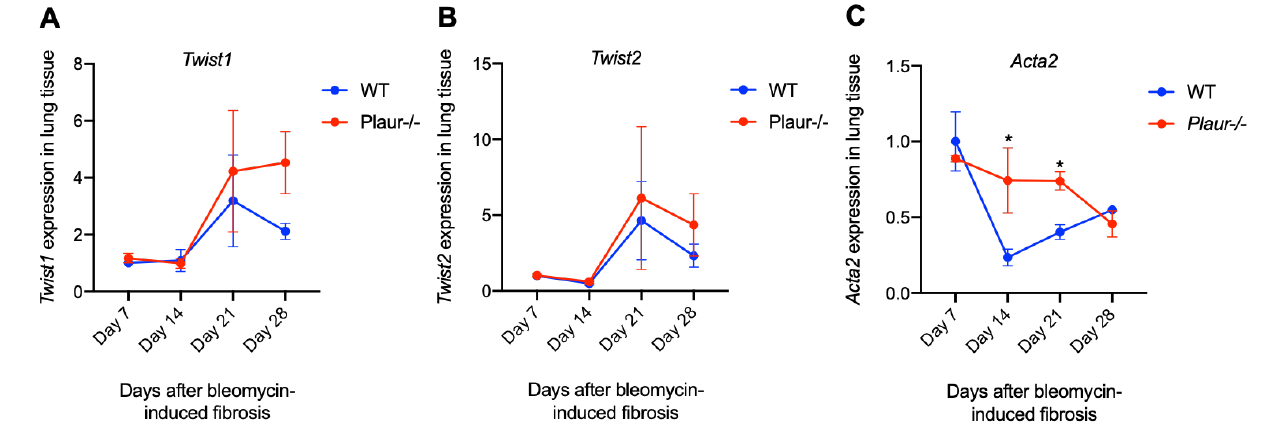
Figure 7. Expression of EMT markers in lung tissue samples of wild-type (WT) and Plaur -deficient ( Plaur -/-) mice after instillation with bleomycin: ( A ) Twist1 , ( B ) Twist2 , ( C ) Acta2 mRNA expression analyzed by RT-qPCR. The mRNA level was normalized to Rpl13a expression as a housekeeping gene, and the normalization was carried out assuming the mean level of transcript in WT cells as 1. Data are presented as the mean ± SEM. * p < 0.05, 2-way ANOVA, Holm–Š í d á k’s